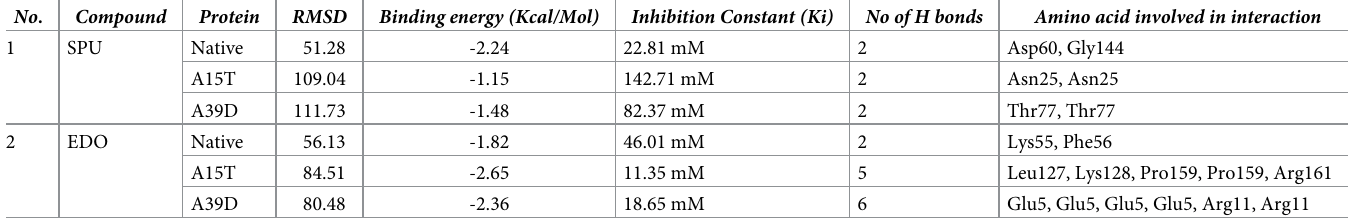
Table 3. Docking results of SPU and EDO ligands with native and mutant proteins. No